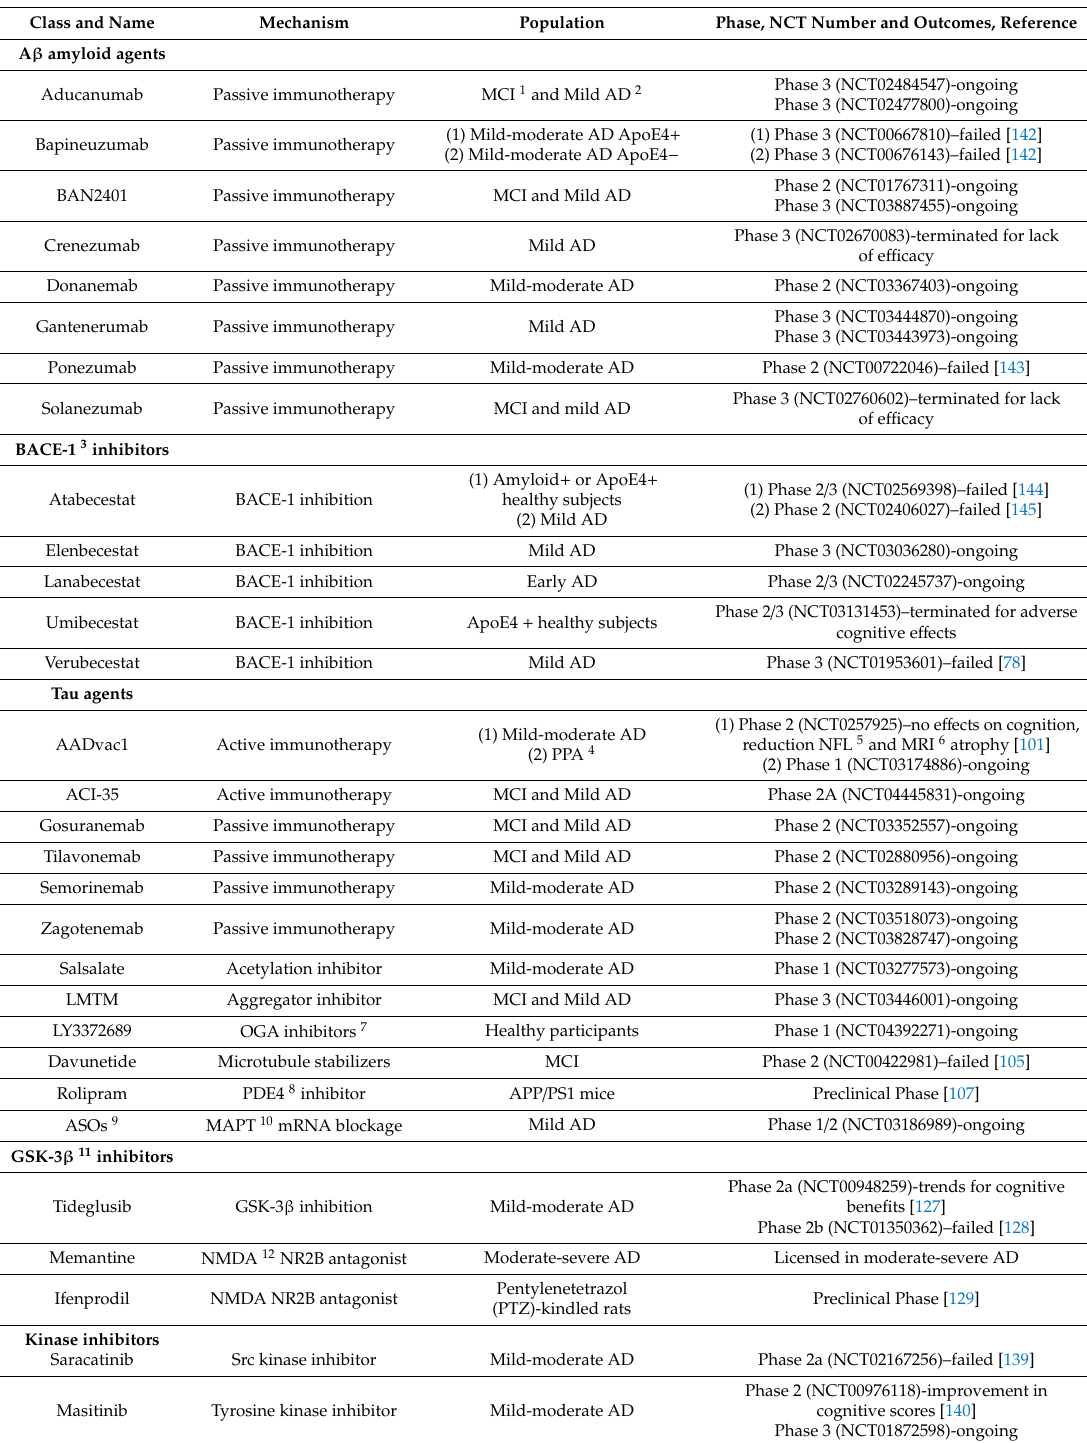
Table 1. Therapeutic strategies targeting A β and tau dependent